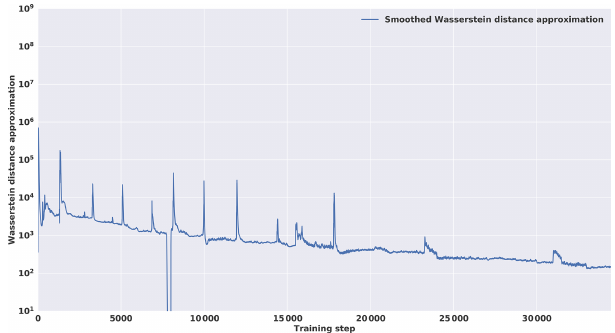
Figure 6. Smoothed version of the Wasserstein distance computed during the training. The vertical axis is in log scale.